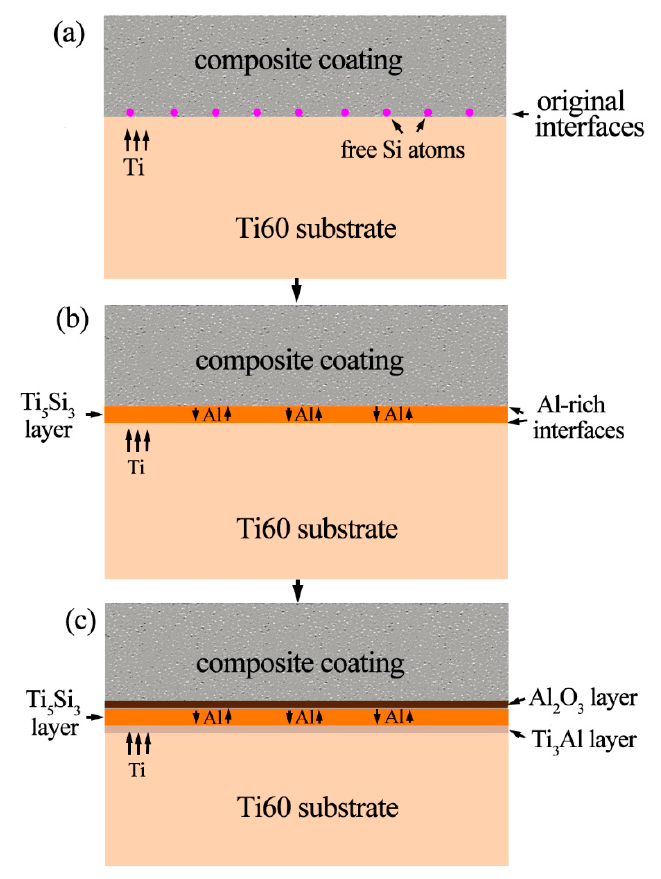
Figure 10. Schematic diagram showing the interfacial reaction between the coating and alloy at high temperature. ( a ) gathering of Si at the interface; ( b ) Al enrichment ; ( c ) formation of the multi-layered structure.